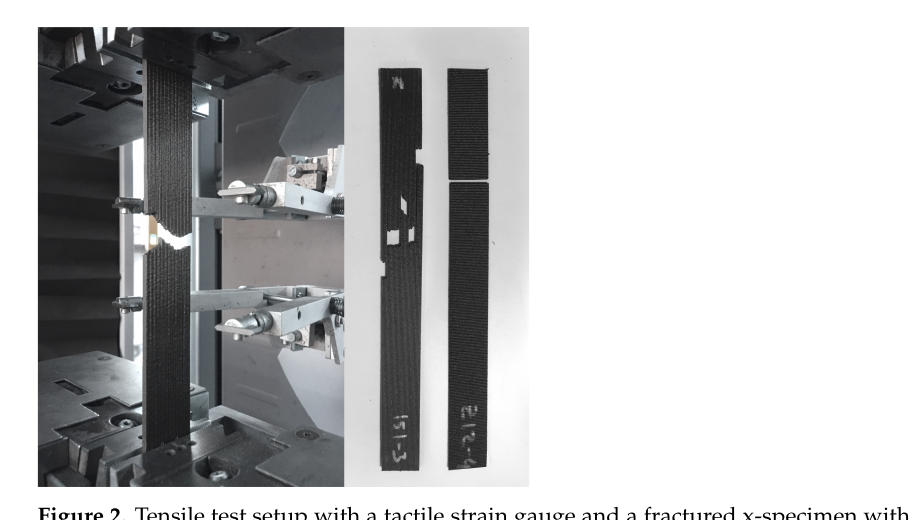
Figure 2. Tensile test setup with a tactile strain gauge and a fractured x-specimen with additional representation of fractured specimens for both the x- and z- direction of